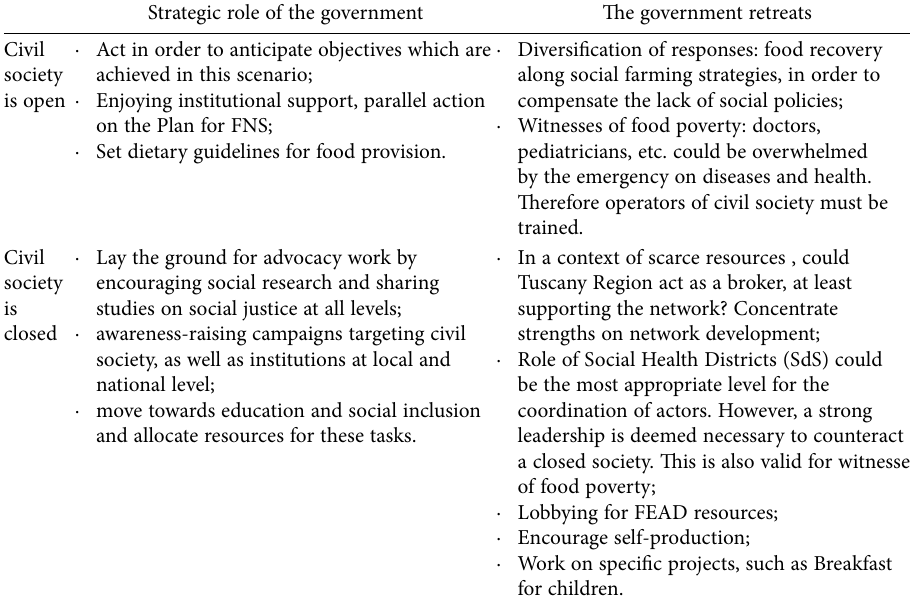
Table 3. Contingency plan for “Person centred